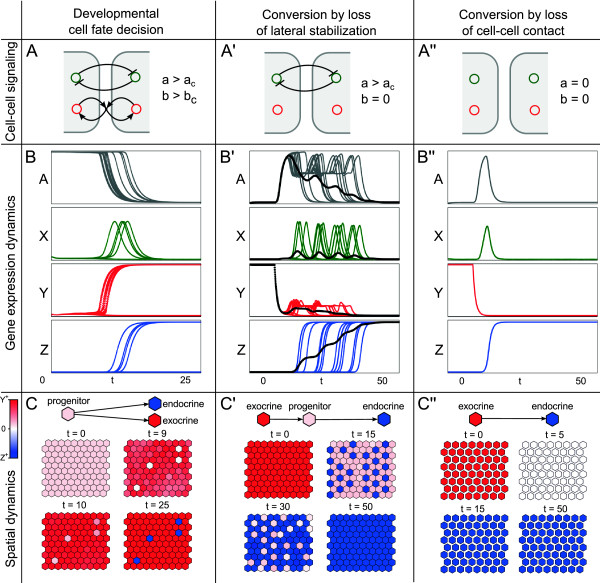
Dynamics of cell fate control. Dynamics of cell fate decisions during development (left column) and lineage conversion (middle and right columns). (A) Sketch of cell-cell signaling condition. (B) Expression of transcription factors over time. A: Hnf6, X: Ngn3, Y: Ptf1a, Z: Isl1. Black lines in B’ depict population averages. (C) Emergent spatial patterns, representing cell fates by colors. Color coding: Y+ acinar cells are red, Z+ islet cells are blue, and Y−Z− cells are white. Initial condition for development is A=1,X=Y=Z=0 and for conversion is Y=1,A=X=Y=0. Parameters as in Table 1. Movies of the spatiotemporal dynamics are available as Additional files (2, 3 and 4).